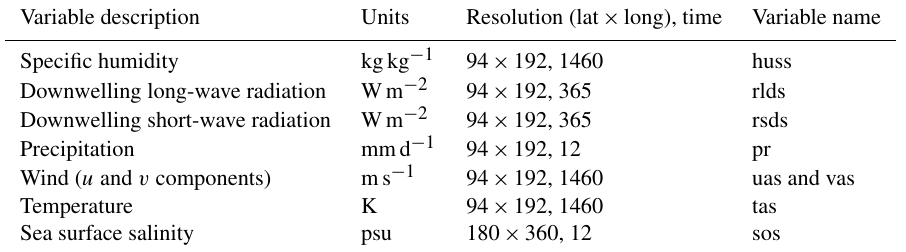
Table 1. Summary of the data showing variable description, units, format (lat × long, time), and NetCDF variable name(s). Formats follow CORE conventions (Large and Yeager, 2004). The wind component variables are provided in separate files (Morée and Schwinger, 2020). In each NetCDF file (i.e. for each variable), the model spread is provided alongside the anomaly field named “variablename_spread”.